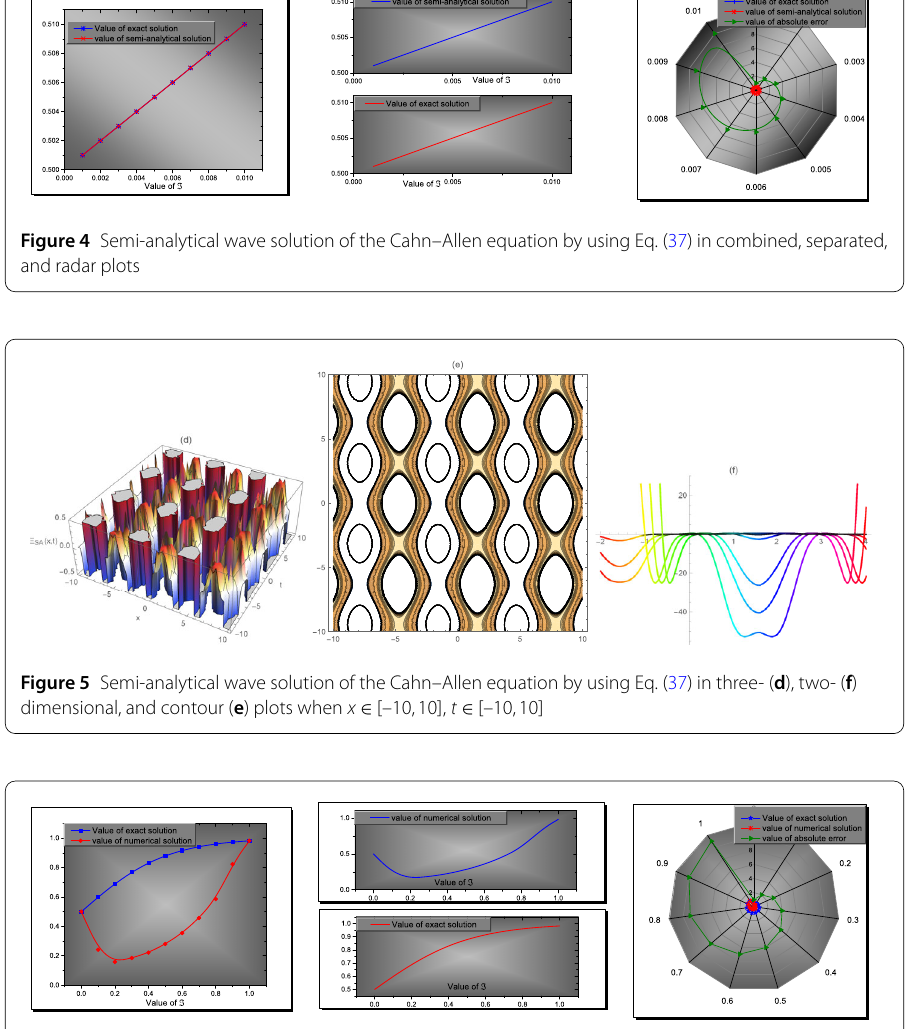
Figure 6 Numerical wave solution of the Cahn–Allen equation in combined, separated, and radar plots